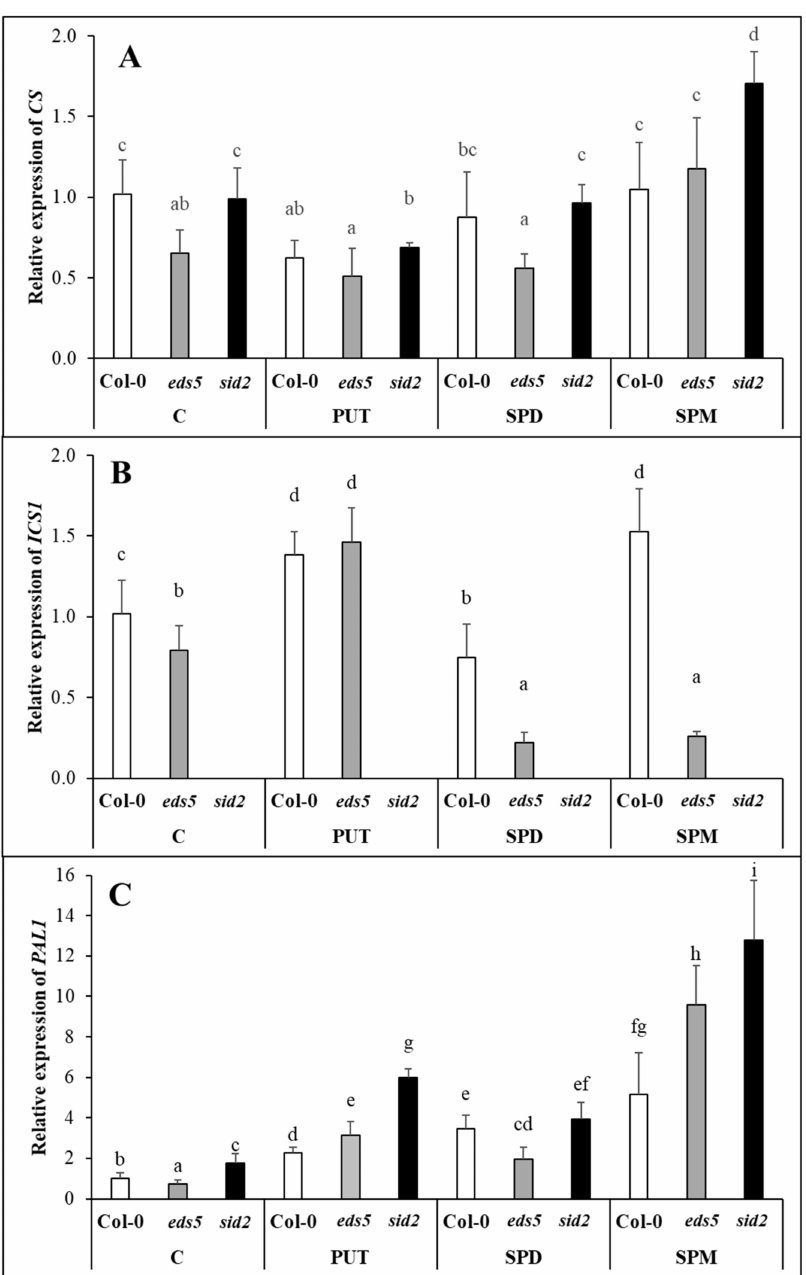
Figure 7. E ff ect of 0.5 mM 1-day of putrescine (PUT), spermidine (SPD) and spermine (SPM) treatments on the expression levels of genes involved in salicylic acid synthesis (( A ) CS : chorismate synthase, ( B ) ICS1 : isochorismate synhtase1, ( C ) PAL1 : phenylalanine ammonia-lyase1) in Col-0, wild type, eds5-1 ( eds5 ) and sid2-2 ( sid2 ) Arabidopsis mutants. Data represent mean values ± SD. Di ff erent letters indicate significant di ff erences at p ≤ 0.05